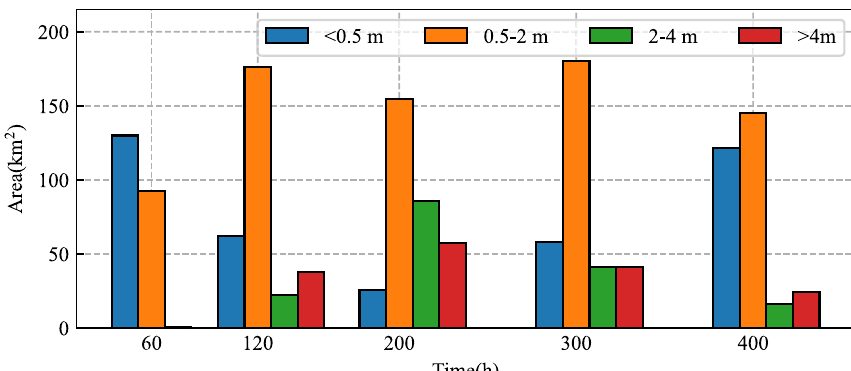
Fig. 6 Water depth and inundation area in different periods of “96.8” flood